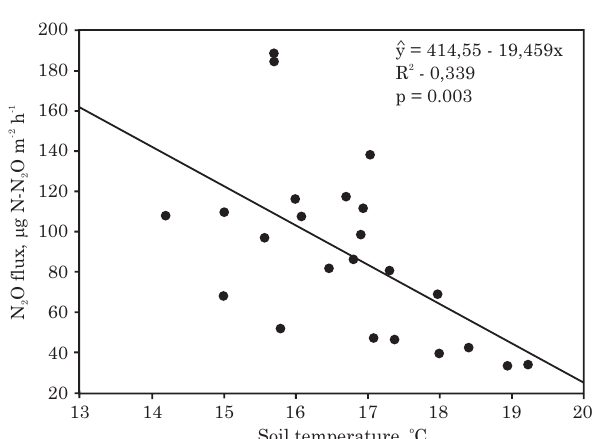
Figure 3. Soil N 2 O emission rates from a Mollisol as a function of soil